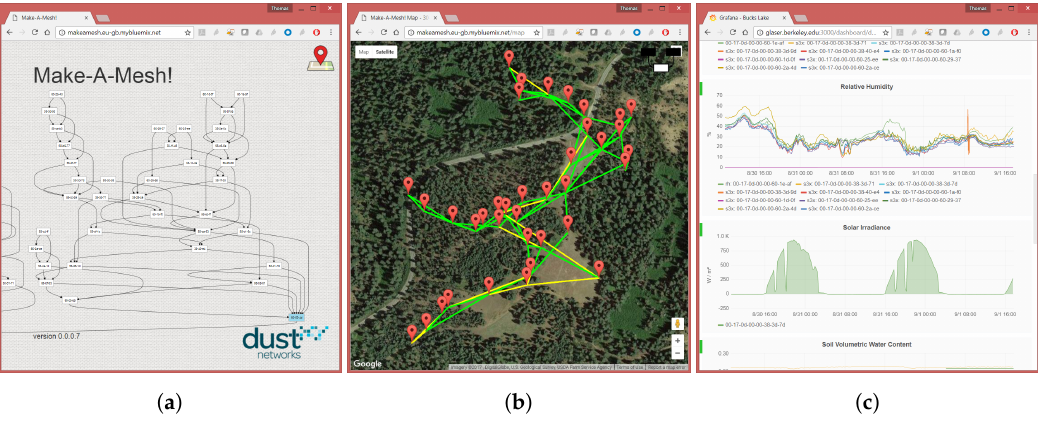
Figure 6. Web frontend (Bucks Lake deployment): ( a ) Topology view; ( b ) Map view; and ( c ) Data